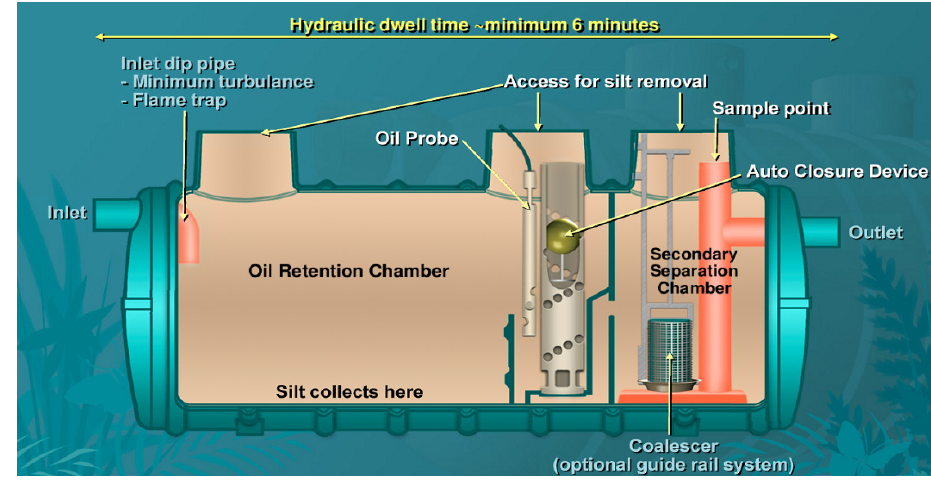
Figure 1. Typical schematic of the Separator technology.